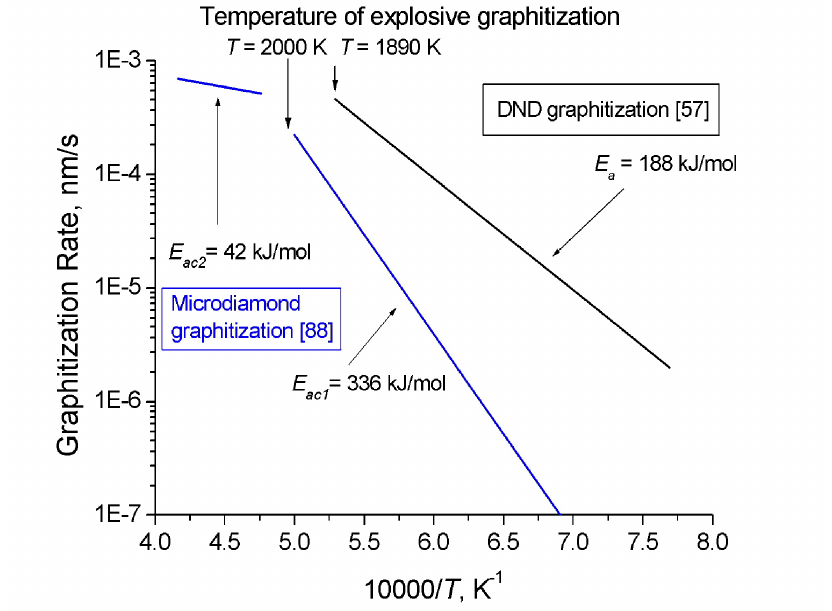
Figure 3. Behavior of microcrystalline diamond [88] and DND [57] graphitization rate with